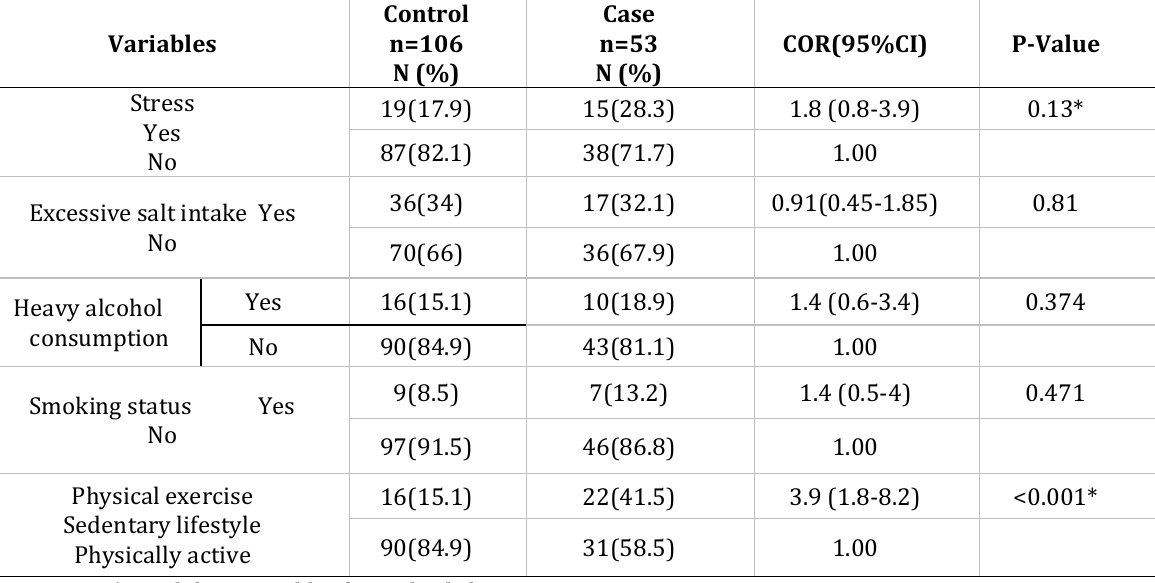
Table 2. Behavioral risk factors among cases and controls at Gondar University Referral Hospital during 2018